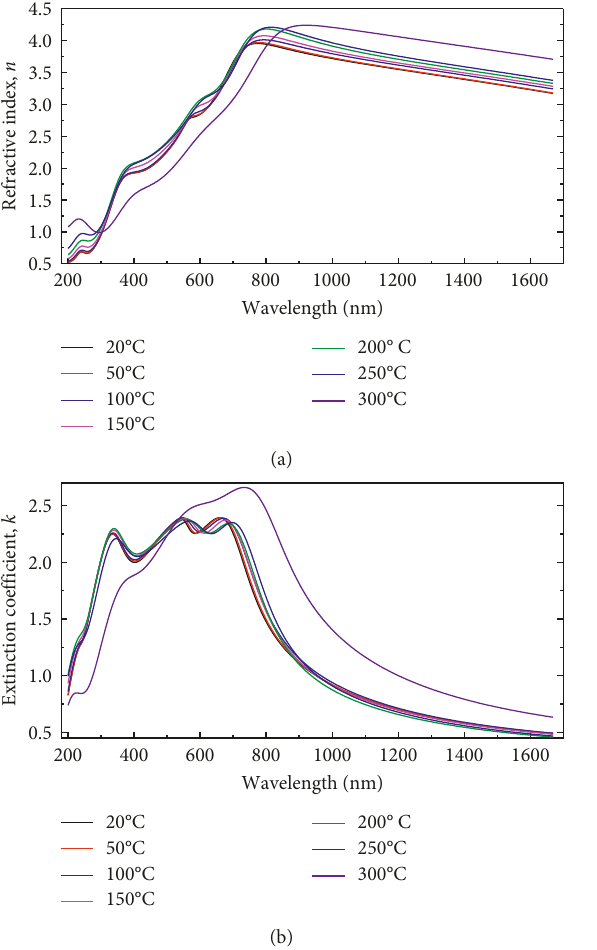
Figure 9: The refraction index n (a) and the extinction coefficient k (b) of InSb thin film (S2) with varied temperatures of 20 ° C–300 ° C.